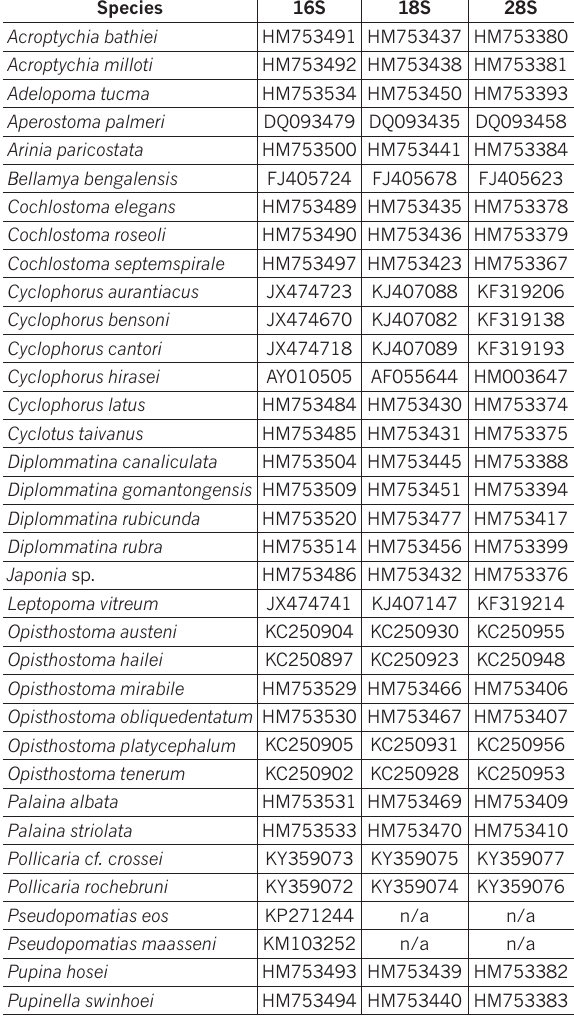
Table 2. Morphological character comparison taken from the original descriptions of Pollicaria rochebruni and P. crossei .